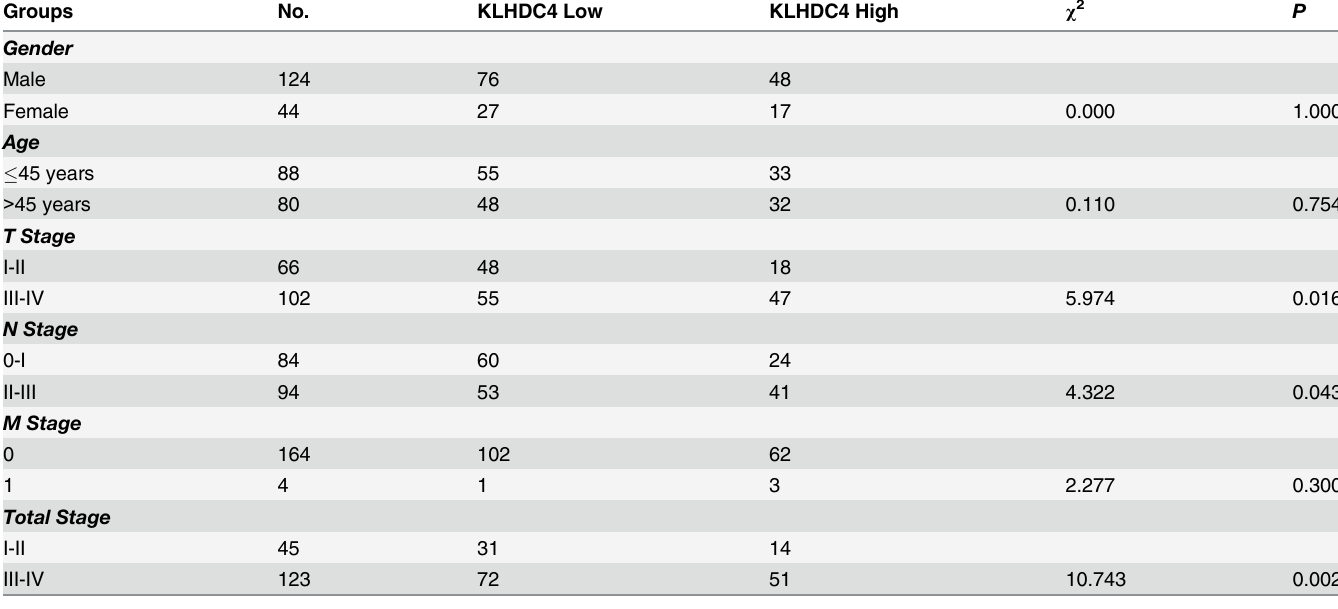
Table 2. Relationship of KLHDC4 expression with clinicopathological characteristics in NPC. Groups